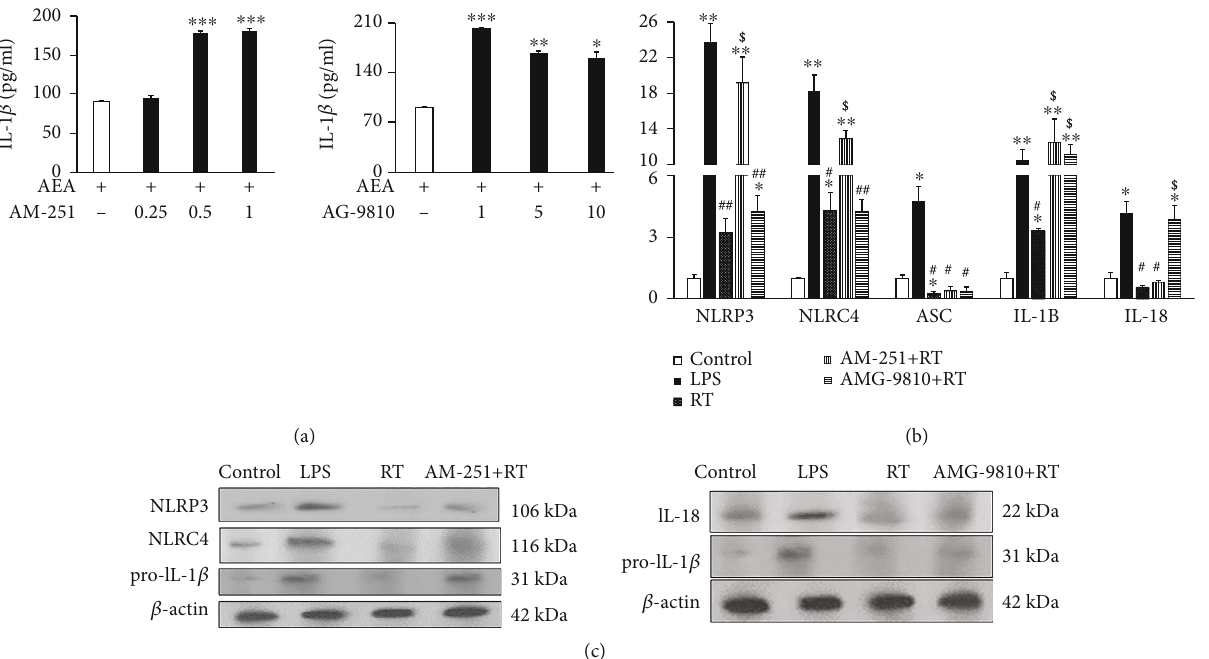
Figure 5: AM-251 and AMG-9810 pretreatment reversed the inhibitory e ff ects of AEA on in fl ammasome components. E ff ect of various concentrations of AM-251 and AMG-9810 on IL-1 β secretion in (b) AEA-treated AGS cells. (b) qRT-PCR and (c) Western blot of in fl ammasome-related genes in LPS-stimulated AGS cells in the presence or absence of AM-251 and AMG-9810. All experiments were performed in triplicate, and the results were obtained from at least two independent experiments. Data are expressed as means ± SEM . ∗ Indicates signi fi cantly changes compared to control group, ∗ p < 0 : 05 , and ∗∗ p < 0 : 01 ; # compared to LPS group, # p < 0 : 05 , ## p < 0 : 01 ; $ compared to RT group and $ p < 0 : 05